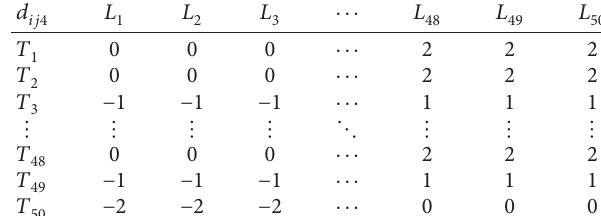
� [ d ] for tenants’ living ij 4 4 50 × 50